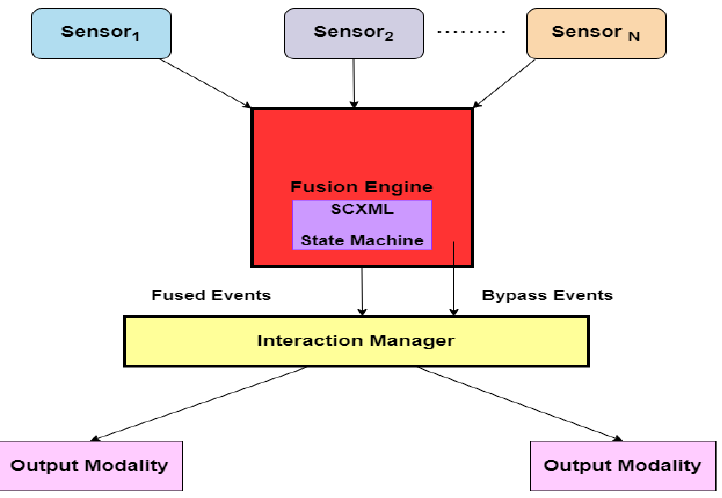
Figure 3. Multimodal fusion